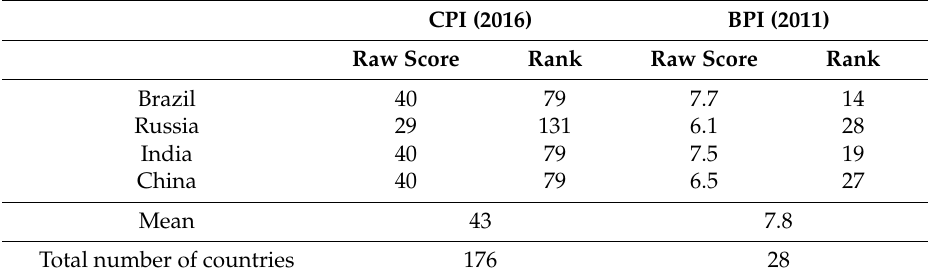
Table 1. Corruption Perceptions Index (CPI) 2016 and Bribe Payers Index (BPI) 2011. CPI